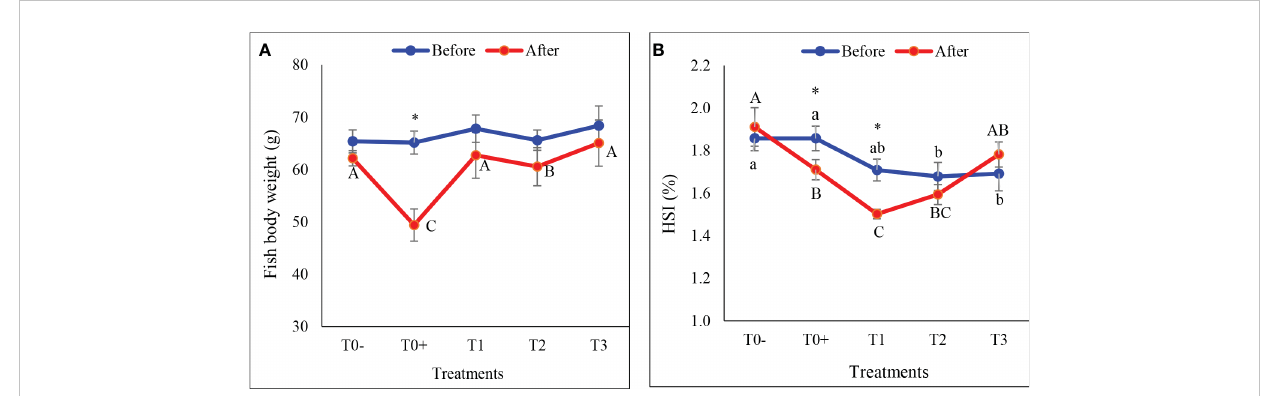
FIGURE 2 Effect of different ratios of corn oil (CO) and Aquafat-O ® (AQ-O) on (A) fi sh body weight (g), and (B) hepatosomatic index (HSI %) of the hybrid red tilapia fed different ratios of CO: AQ-O and exposed to cold stress. T 0- (the negative treatment); T 0+ (the positive treatment); T 1 (2 CO: 1 AQ-O); T 2 (1 CO: 2 AQ-O); T 3 (3 CO: 0 AQ-O). Vertical bars indicate the standard errors; means with an asterisk indicate a signi fi cant difference between before and after the exposure to cold stress ( p < 0.05). Small and capital letters indicate signi fi cant differences among treatments before and after exposure to cold stress,